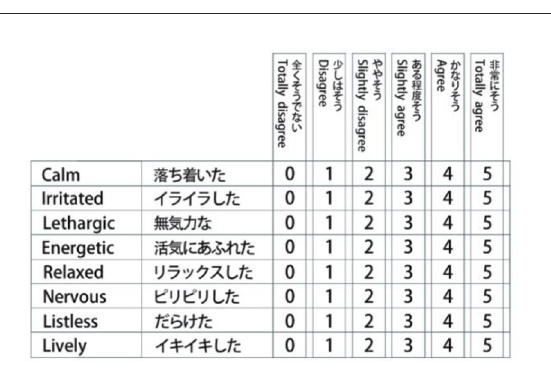
FIGURE10 Two-Dimensional Mood Scale (TDMS) in English and Japanese. TABLE 5 Semantic Differential